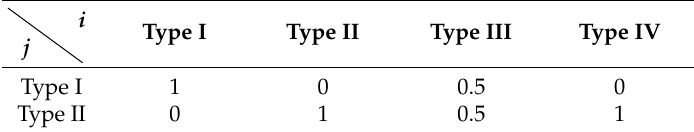
Table 1. Correlation of two blocks in the rightmost piece and the leftmost